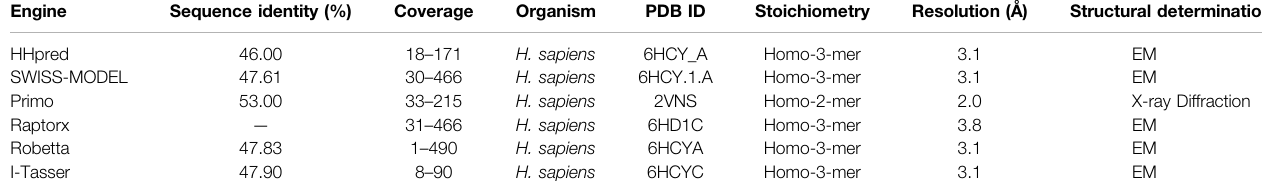
TABLE 2 | Top homology modeling templates from selected model engines and respective parameter of the hits.